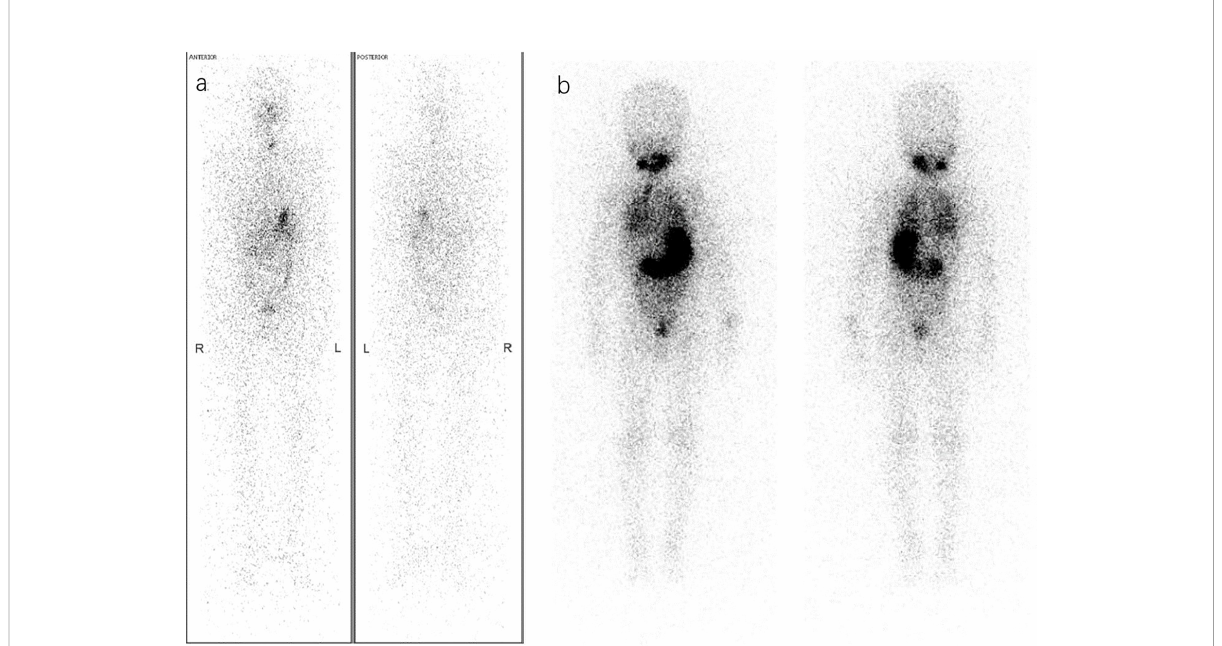
FIGURE 1 Different RAT considerations via Dx-WBS. (A) A 36-year-old woman was diagnosed with PTC (pT1bN1bM0, ATA intermediate-risk) by pathology after thyroidectomy and lymph node dissection. Considering both the postoperative disease status of ps-Tg<0.04 ng/ml and A-Tg 111 IU/ml with a decreasing trend and Dx-WBS fi ndings that did not indicate suspicious concealed lesions, she may not bene fi t from RAT. Therefore, she received TSH suppression therapy instead of RAT. (B) A 4-year-old boy under thyroidectomy was con fi rmed pathologically to have PTC (pT1aN1aM0, ATA low-risk) in 2008. Surprisingly, Dx-WBS revealed wide uptake of 131 I in the lungs, whereas preoperative CT did not. Through 3 times of 60 mCi RAI, he obtained and has maintained an excellent response (ER) in recent years (1 st RAT: TSH >150 m IU/mL, Tg 91 ng/ml, A-Tg 13.25 IU/ml; 2 nd RAT: TSH >150 m IU/mL, Tg 9.4 ng/ml, A-Tg 10 IU/ml; 3 rd RAT: TSH >150 m IU/mL, Tg 3.4 ng/ml, A-Tg 10 IU/ml; the latest follow-up: TSH 0.244 m IU/mL, Tg<0.04 ng/ml, A-Tg 15